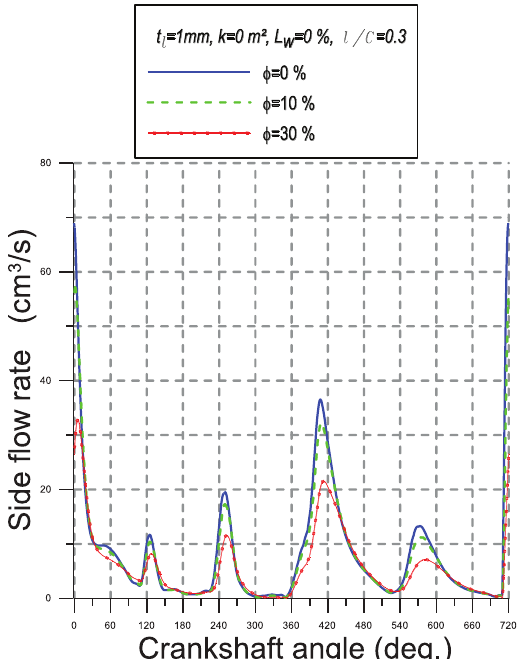
Fig. 21. Effects of the nanoparticles concentration parameter on side leakage fl ow over an engine cycle.